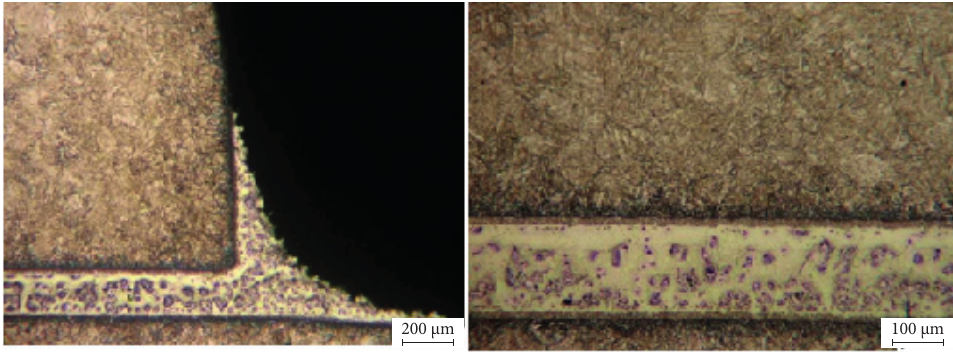
Figure 8. Metallographic inspection of brazing